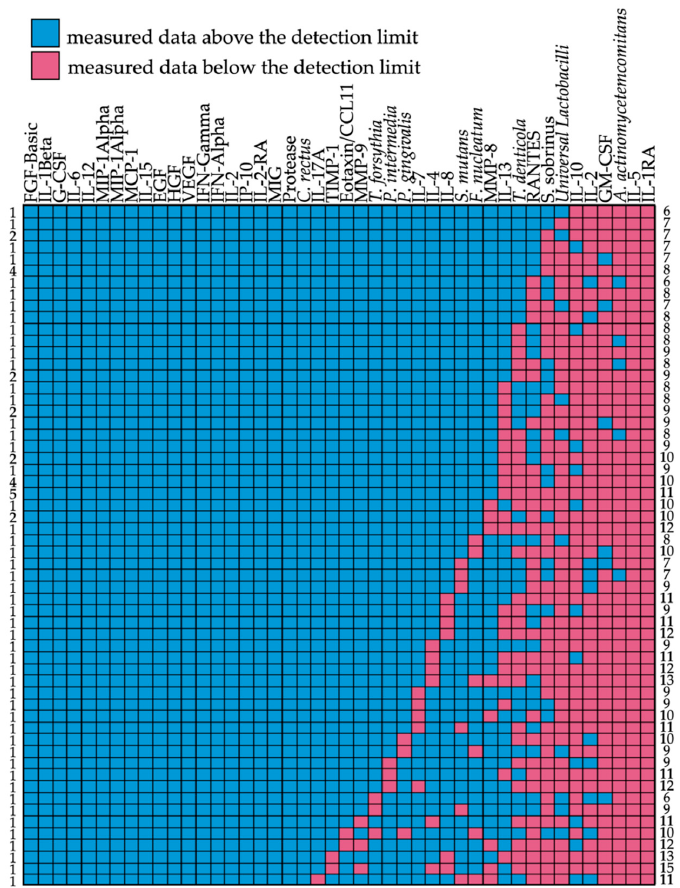
Figure 2. Detection matrix of all biomarkers (x-axis) in the analyzed 73 subjects (y-axis). Color codes show data measured above (blue) or below (red) the detection limit. Numbers on the left correspond to the numbers of patients with the same pattern of biomarkers above/below the detection limit. Numbers on the right represent the numbers of biomarkers below the detection limit per line.